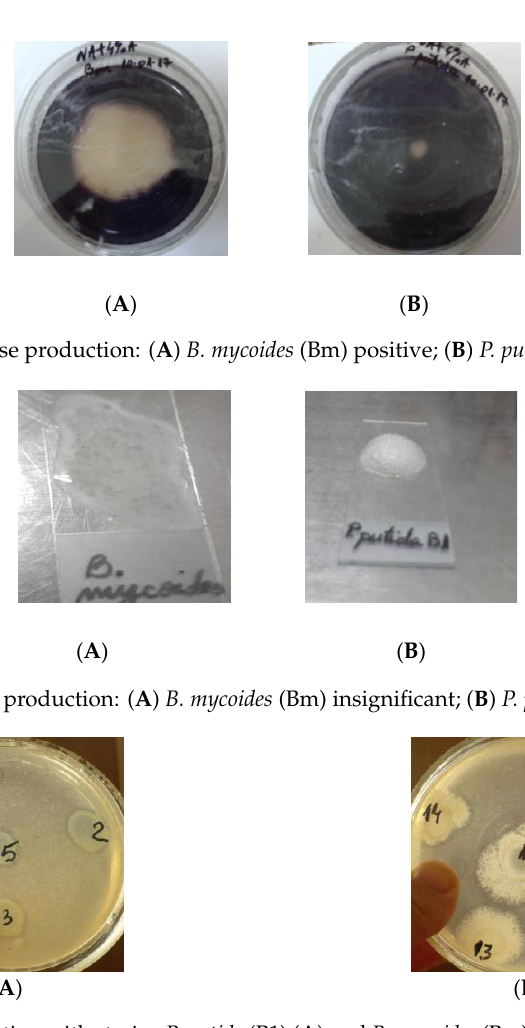
Figure 8. Lipase production with strains P. putida (B1) ( A ) and B. mycoides (Bm) ( B ) (inocula from media: NA (1 and 11), KB (2 and 12), LB (3 and 13), M44 (4 and 14), YMPG (5 and 15)). The enzymatic activities measured for amylase (enzymatic assay of α -Amylase EC 3.2.1.1, with DNS, [30]), lipase (enzymatic assay of lipase EC 3.1.1.3, titrimetric method, [31]), and catalase (enzymatic assay of catalase EC 1.11.1.6, [32]), following the Sigma-Aldrich protocols, revealed that: